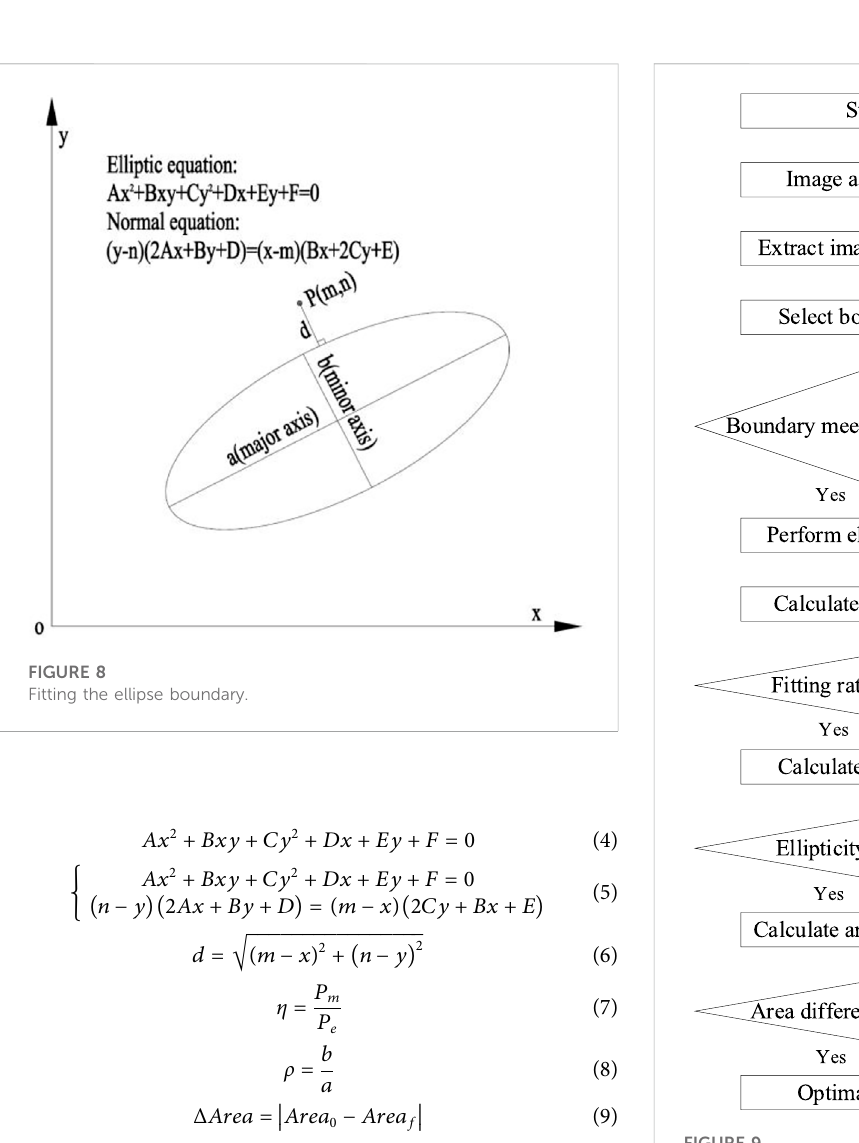
FIGURE 9 Algorithm fl ow